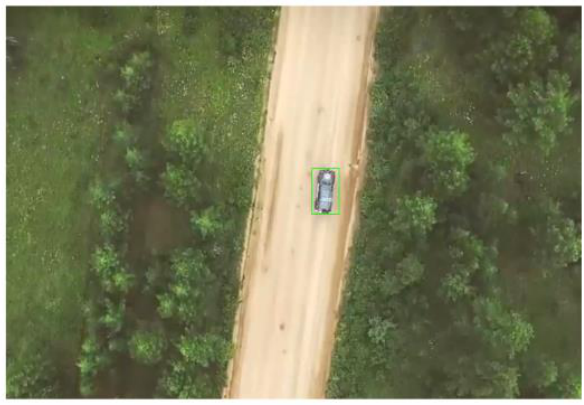
Figure 12. Tracking and localization of a car.